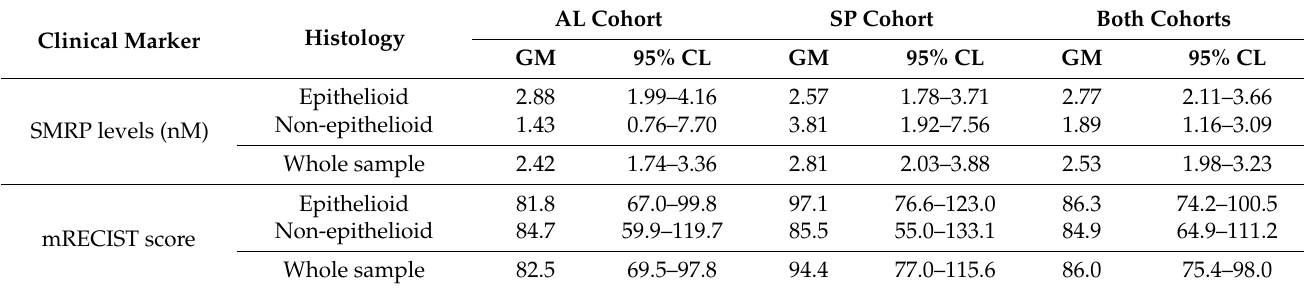
Table 2. Determinations of SMRP levels and mRECIST score in all MPM patients and by histological subtypes. Clinical